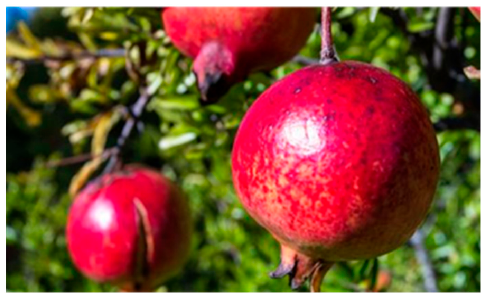
Figure 4. Pomegranate ( Punica granatum L.).